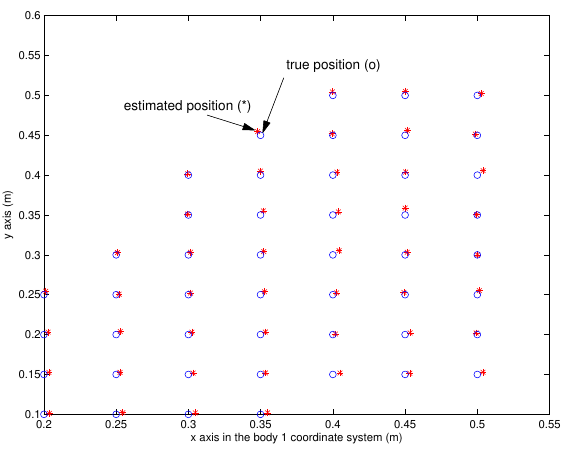
Figure 10. Vision-based position estimation accuracy experiment results in the body 1 coordinate system.